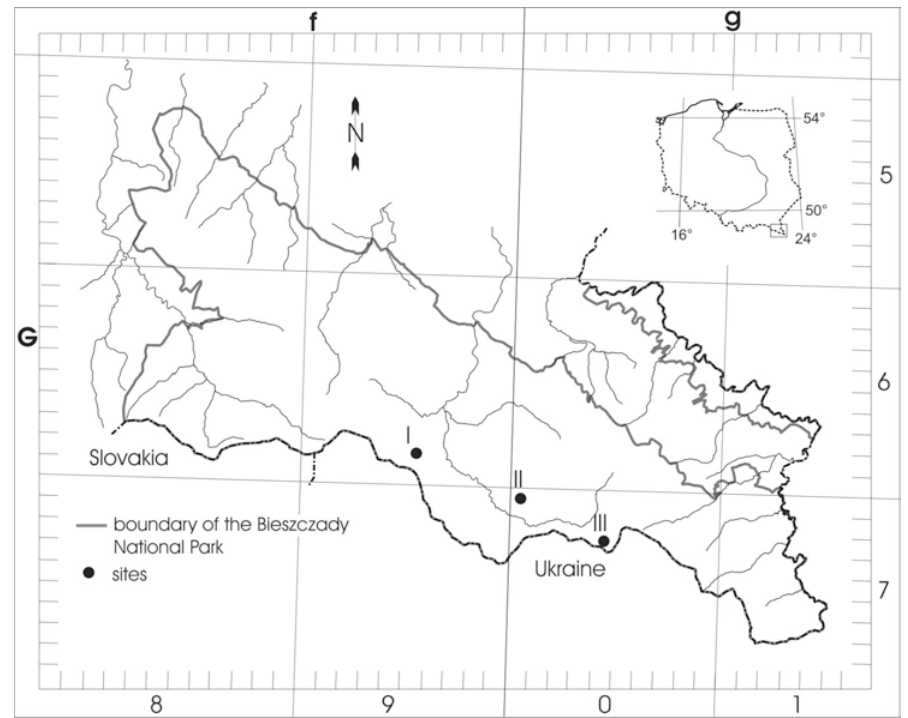
Fig. 1. Distribution of the sites of Usnea florida in the bieszczady national Park on a back- ground of atPol